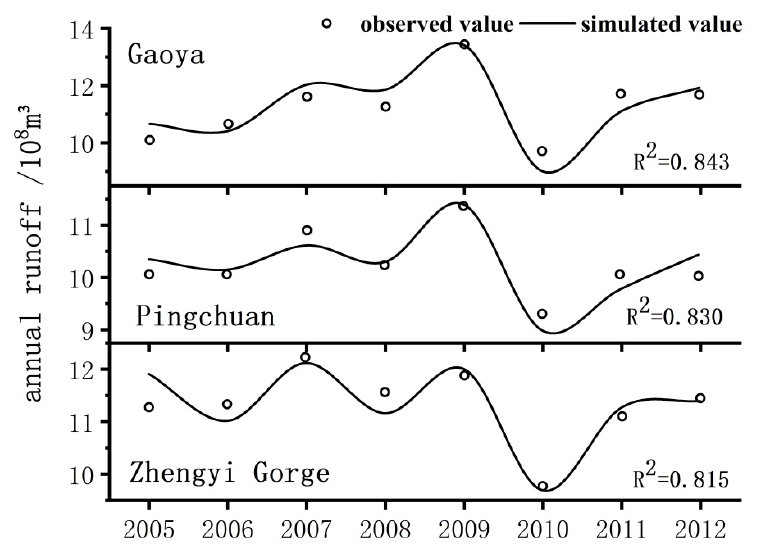
Figure 7. Annual runoff simulation of the controlled section of the middle reaches of Heihe River.